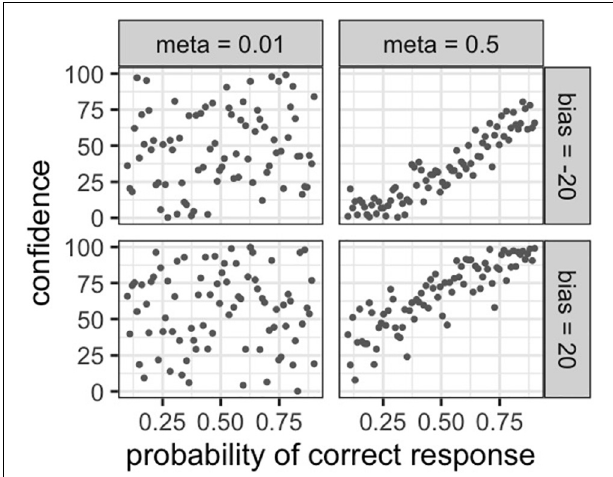
FIGURE 3 | Simulation of the association between the probability of a correct answer and confidence in different metacognitive ability and bias.